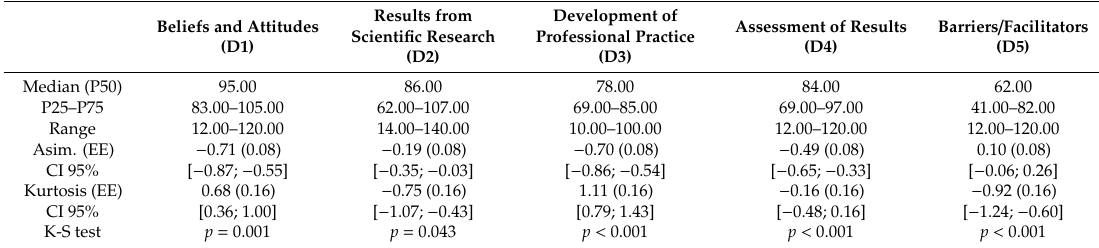
Table 2. Descriptive statistics and normality tests of Health-Sciences Evidence Based Practice (HS-EBP) dimensions.